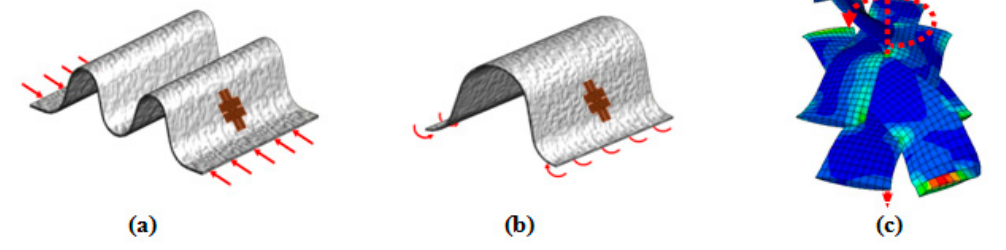
Figure 1. Wrinkles formed due to ( a ) in-plane compression; ( b ) out-of-plane bending and ( c ) in-plane shear.